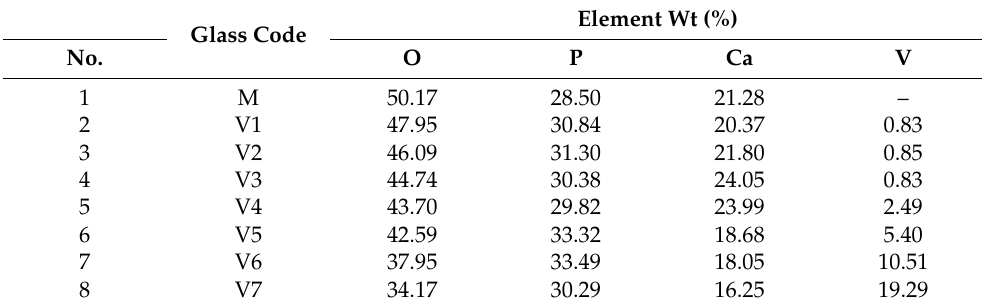
Table 1. The chemical elements present in the surface of glass powders evaluated by EDS spectroscopy. Glass Code